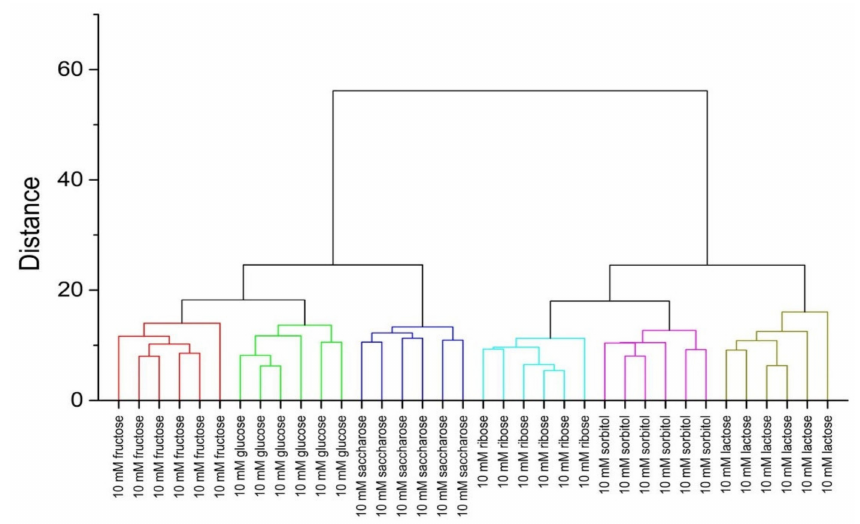
Figure 6. Hierarchical clustering analysis (HCA) dendrogram for samples containing studied receptors, ARS, and saccharides (10